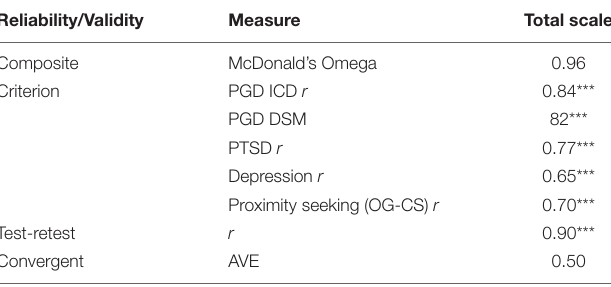
TABLE 3 | Psychometric validity of the OG-Loss-related memory characteristics